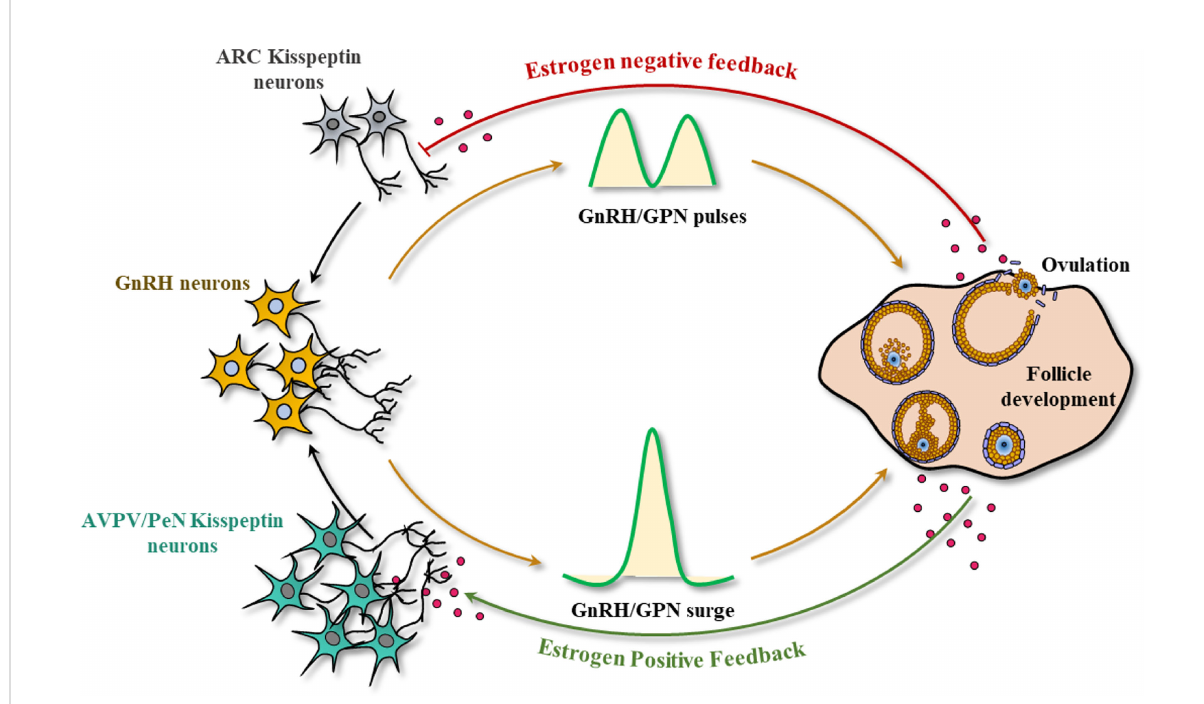
FIGURE 2 Kisspeptin signaling in the hypothalamic-pituitary-gonadal axis. In most mammals, there are two major sites of kisspeptin (KP) expression in the hypothalamus: the infundibular nucleus, and the nuclei in preoptic area (PeN) (arcuate nucleus (ARC) and anteroventral periventricular nucleus (AVPV) in rodents). Small amounts of estrogen synthesized from the ovary results in the activation of KP neurons in the infundibular/ARC nucleus, modulating the pulsatile secretion of GnRH and gonadotropins (GPNs). In contrast, an increased level of estrogen during the follicular phase (analogous to proestrus stage) activates the KP neurons in PeN/AVPV and inhibits the infundibular/ARC neurons, generating the GnRH/ GPN surge, enabling oocyte maturation, and